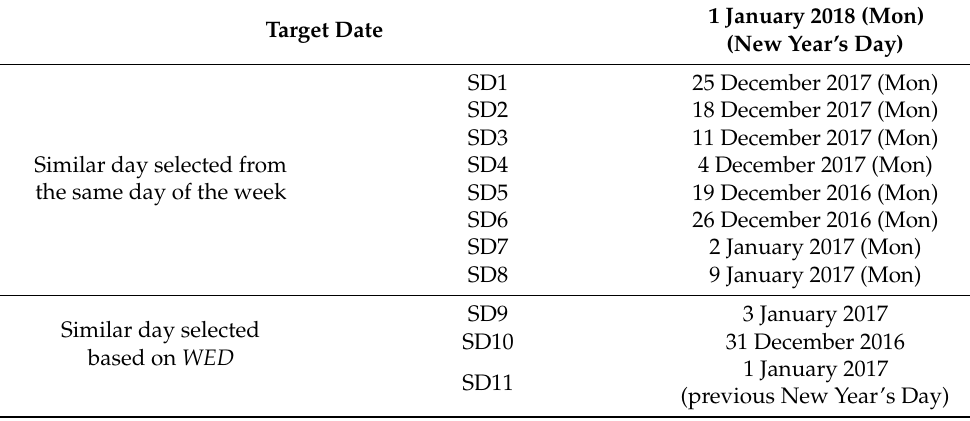
Table 4. Example of the new similar days selection